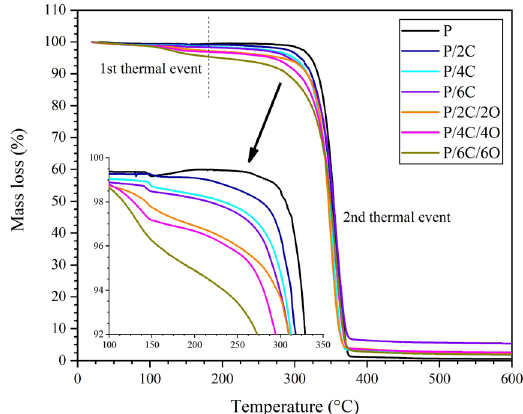
Figure 4. DTGA curves of the films produced, with emphasis on the T , which refers to the maximum degradation temperature dmax of the